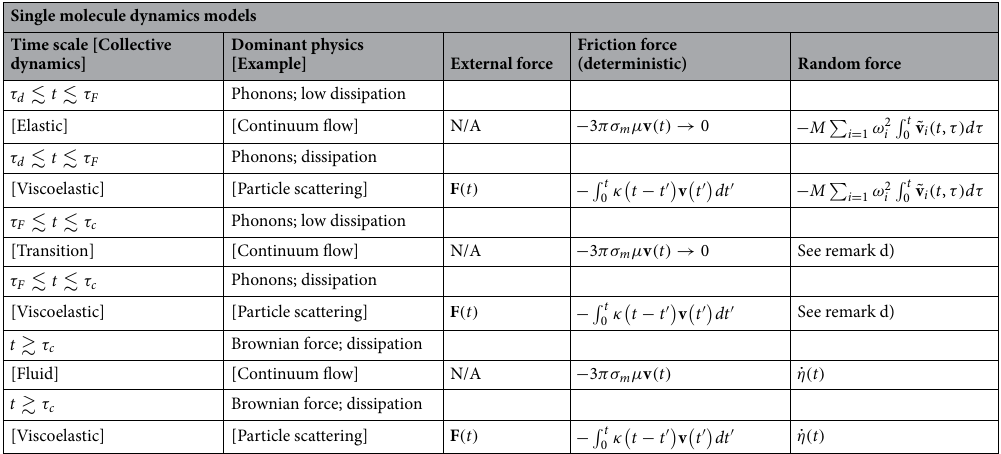
Single molecule dynamics